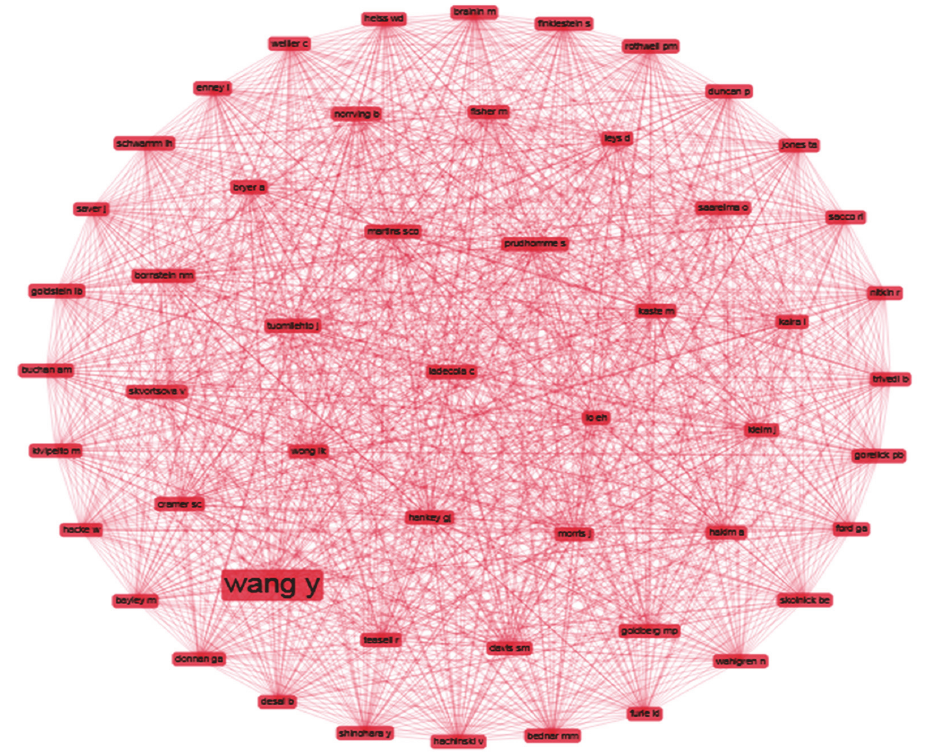
Fig. 4. Author’s Collaboration Network